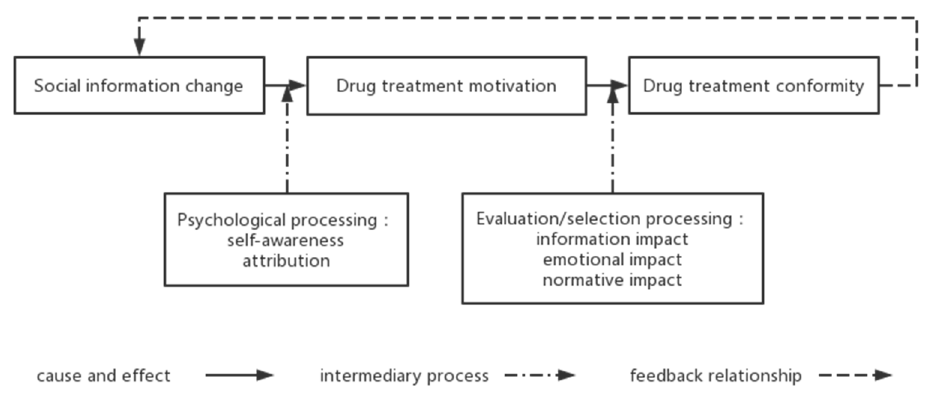
Figure 1. The development of drug treatment conformity among young drug users.